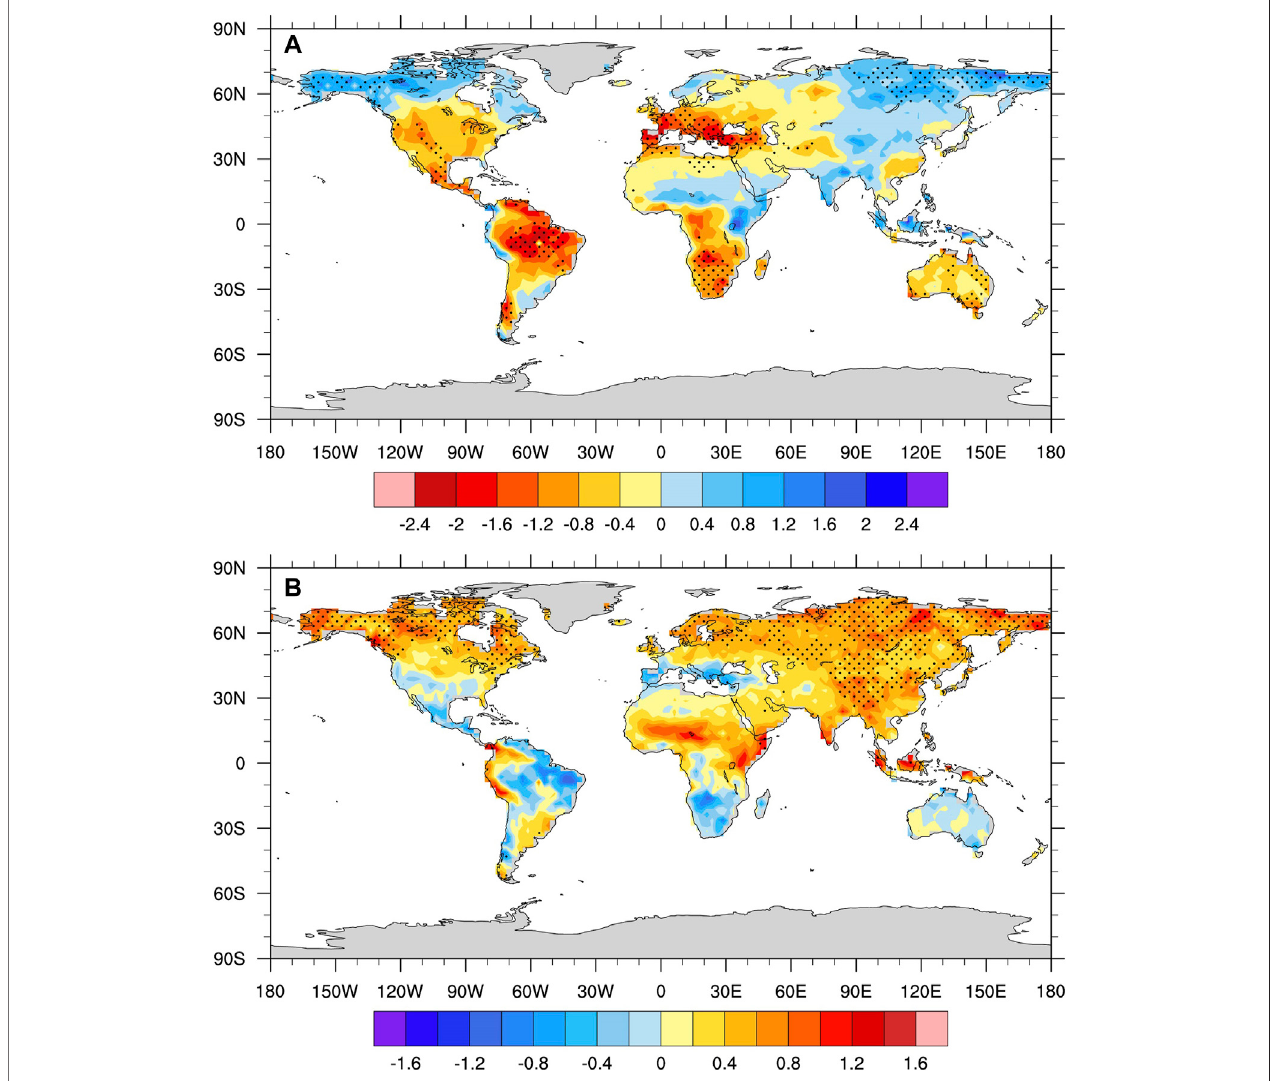
FIGURE 1 | Multi-model ensemble averaged changes in the PDSI (A) mean value and (B) standard deviation from 1970 – 1999 to 2070 – 2099 under the RCP4.5 emission scenario. Black dots represent the sign change agreement for more than 80% of the model.